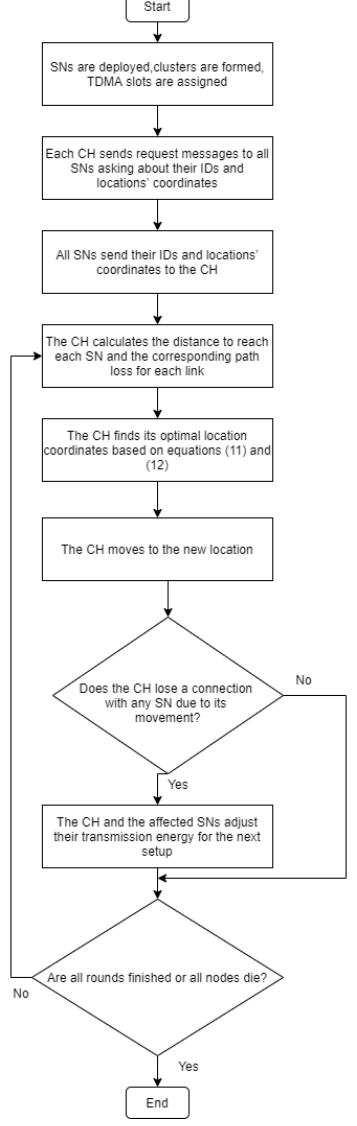
Figure 4. The flow chart of the Cluster Head Positioning algorithm .